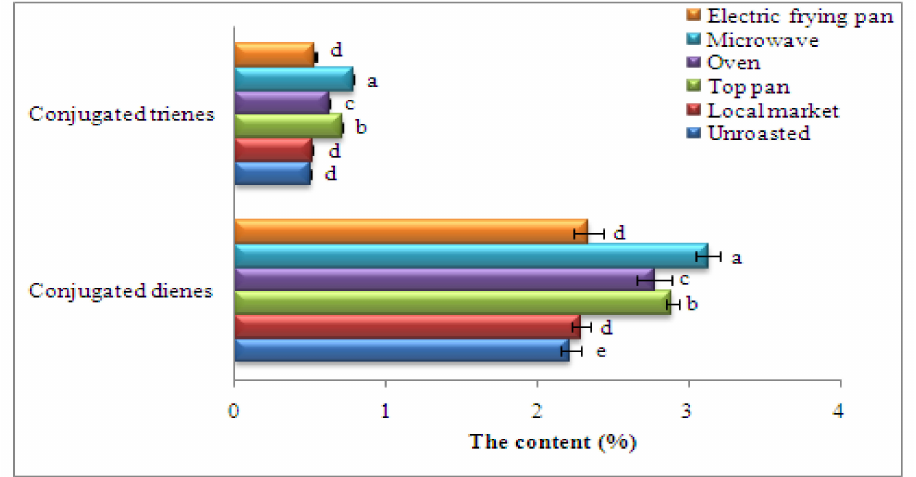
Figure 2. Conjugated diene and conjugated triene percentages in oils recovered from sesame seeds roasted by different methods. Significant variations at p ≤ 0.05 are indicated by vertical bars with SD (n = 3) and different letters on the bars of every